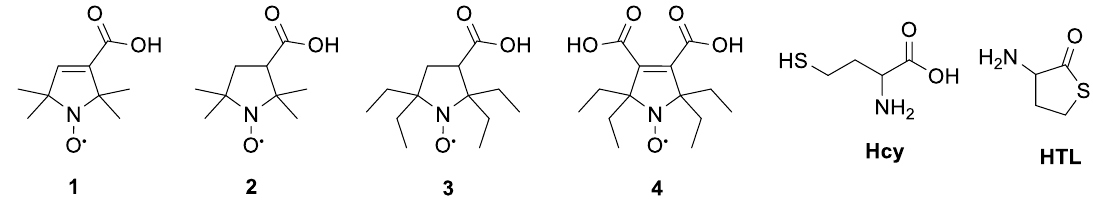
molecules. molecules.